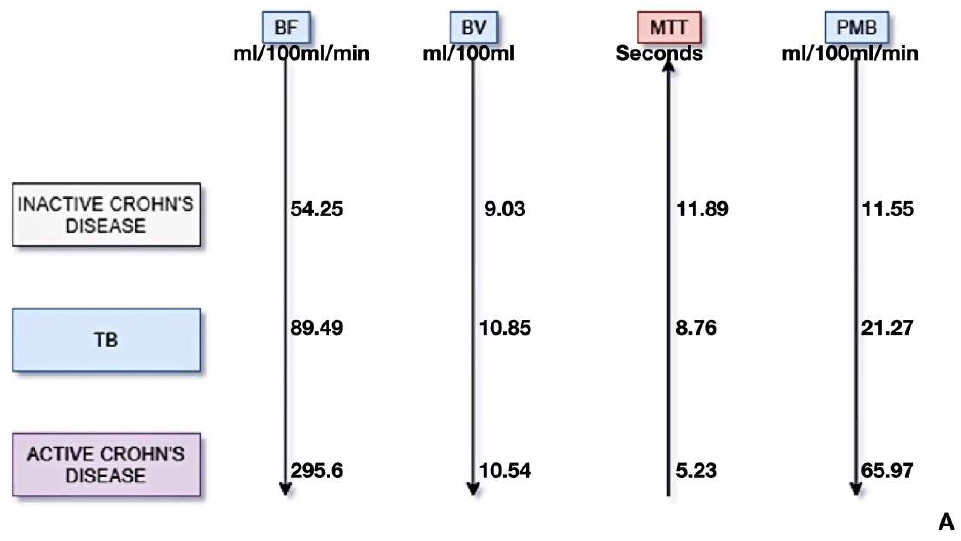
Table 1. Mean perfusion CT parameters in the three groups.